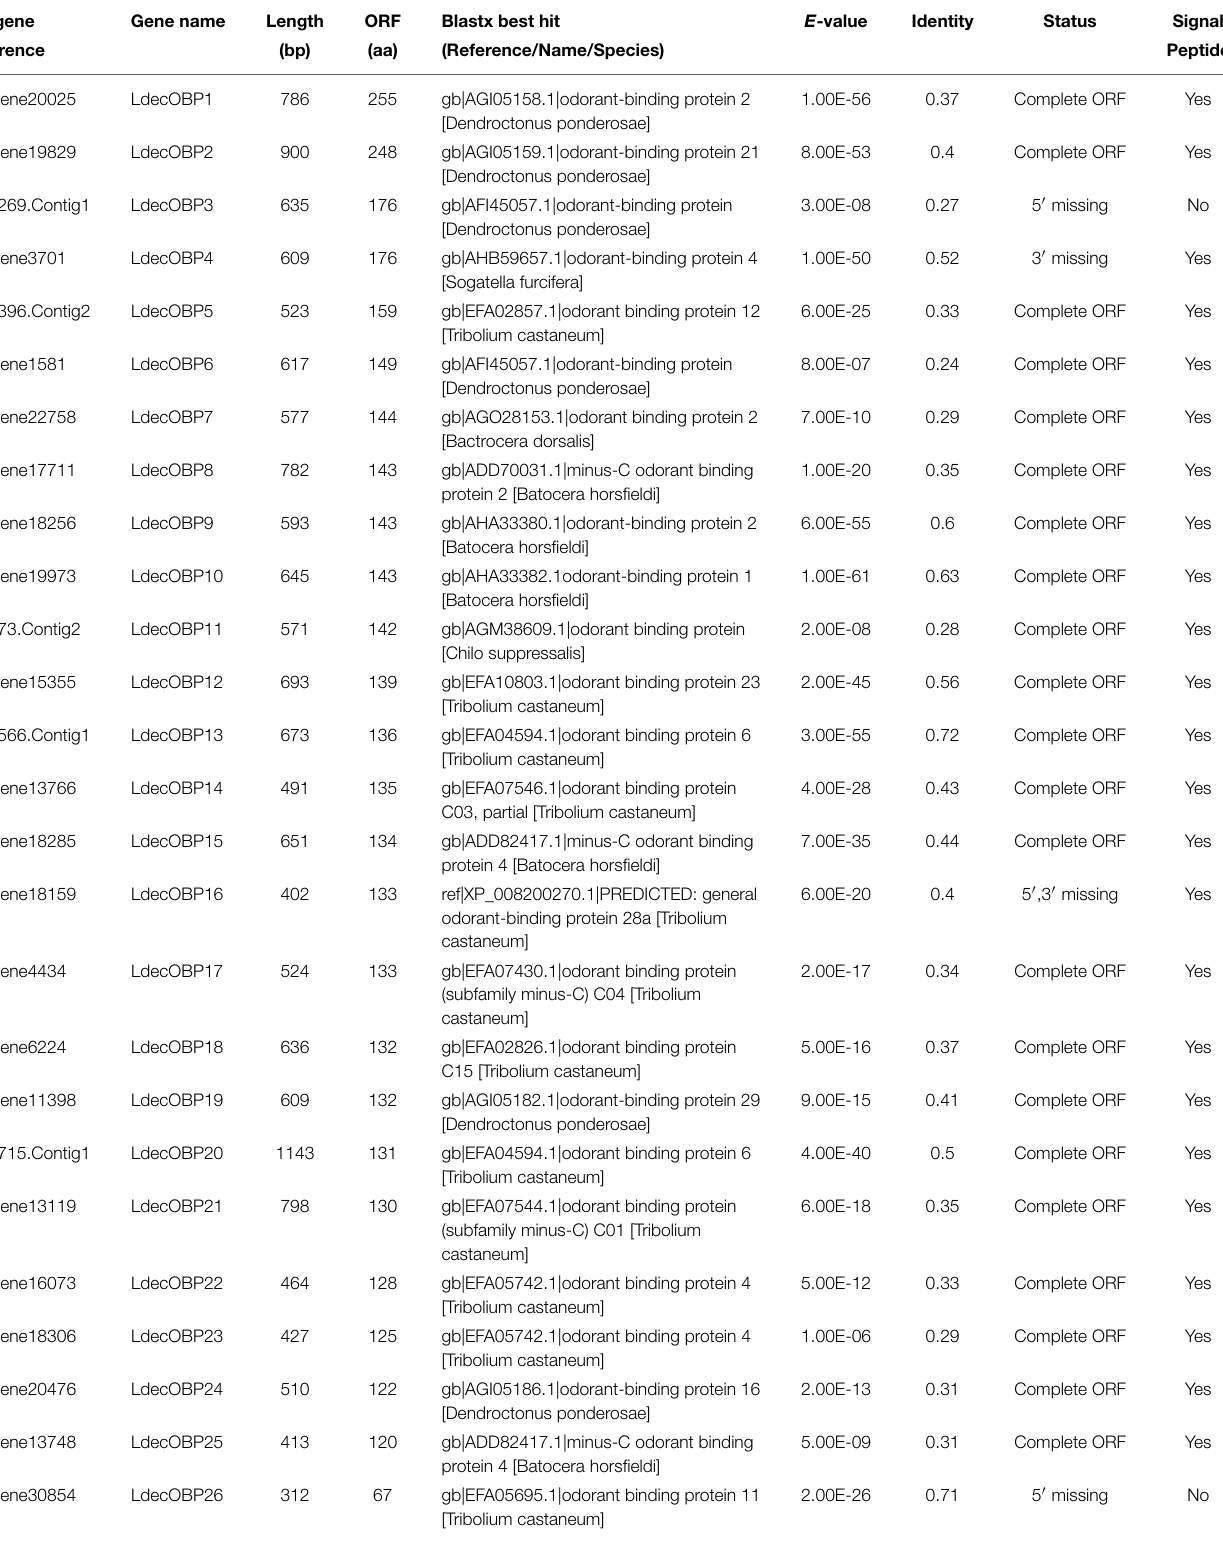
TABLE 2 | Unigenes of candidate odorant binding